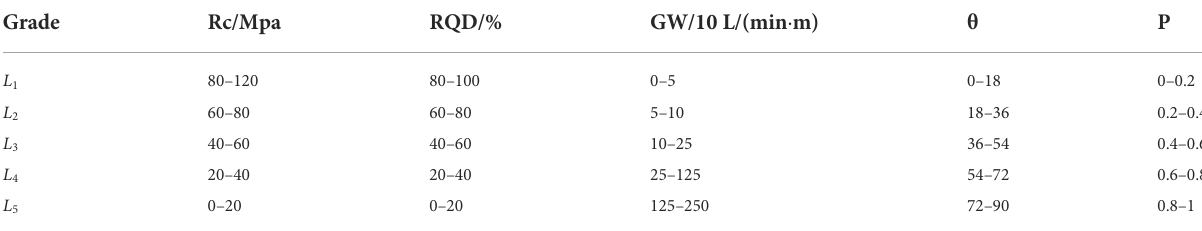
TABLE 4 Classi fi cation standard for tunnel